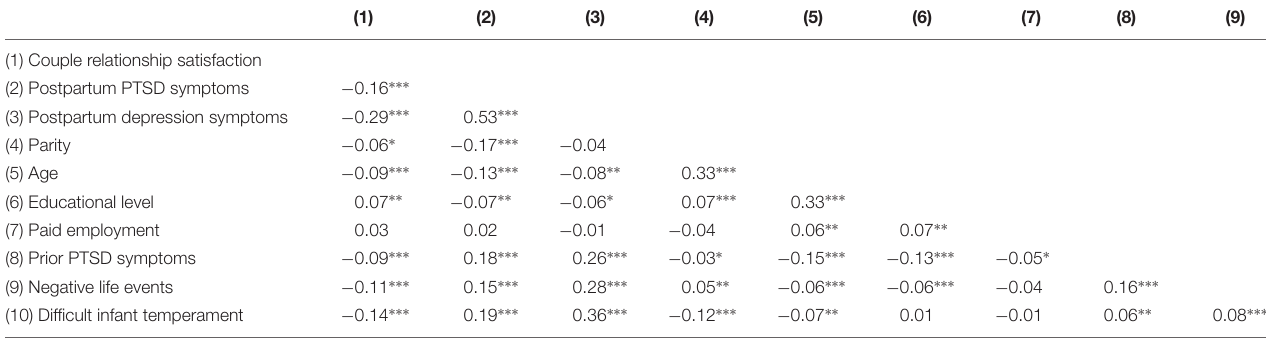
TABLE 2 | Intercorrelations between all included study variables.